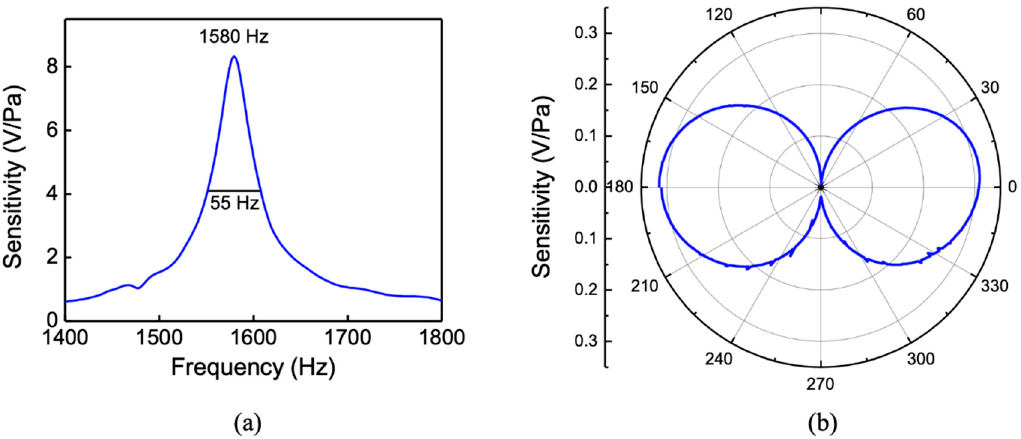
Figure 12. Measured ( a ) sensitivity and ( b ) directivity pattern of the sensor in air. The directivity pattern was measured at 1580 Hz.